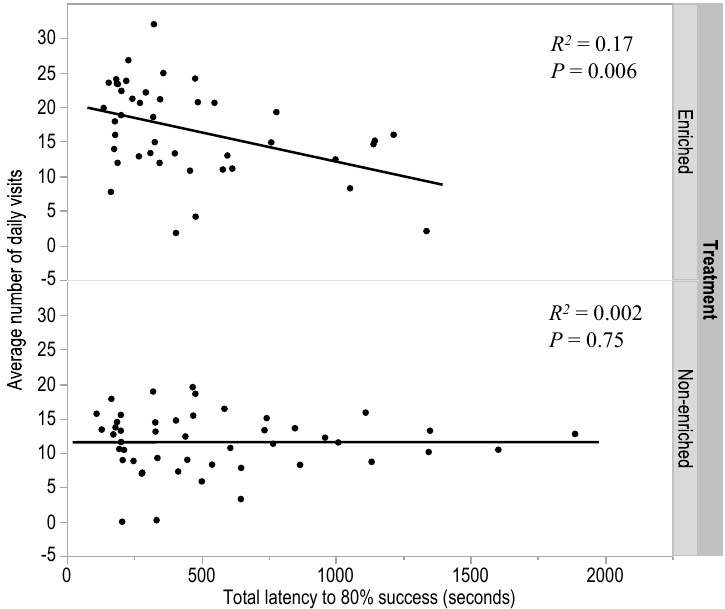
Figure 5. The regression between the total latency to reach the minimum 80% success criterion in T-maze learning and the average number of daily visits to the range for birds from enriched and non-enriched early rearing treatments.